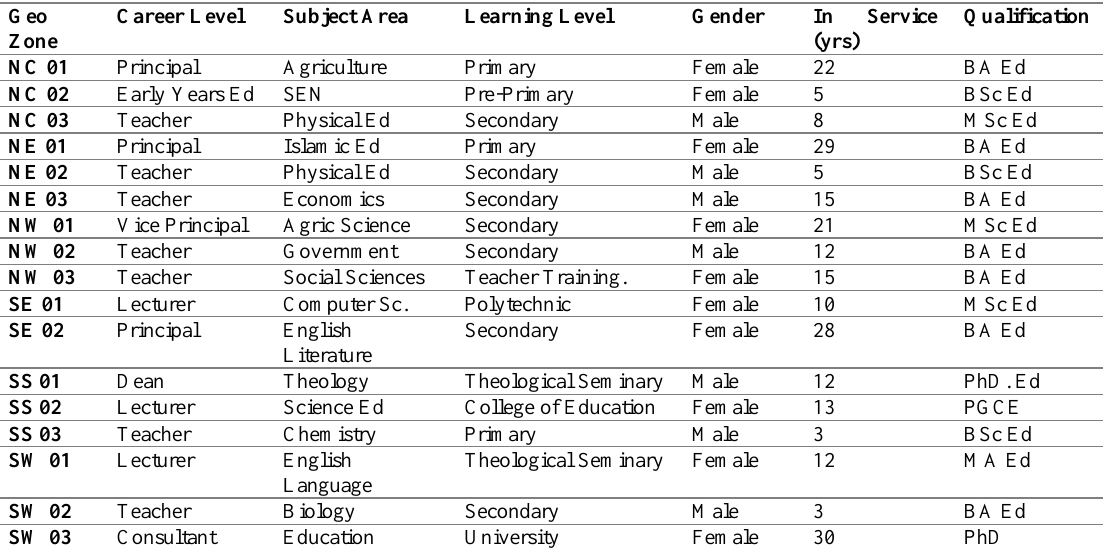
Table 4: Demographic characteristics of participants